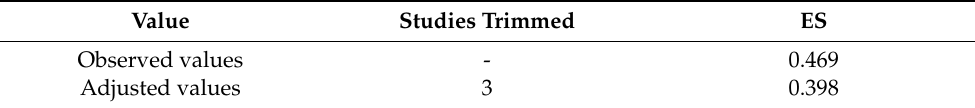
Figure 3. Funnel plot. Table 6. Analysis of trim and